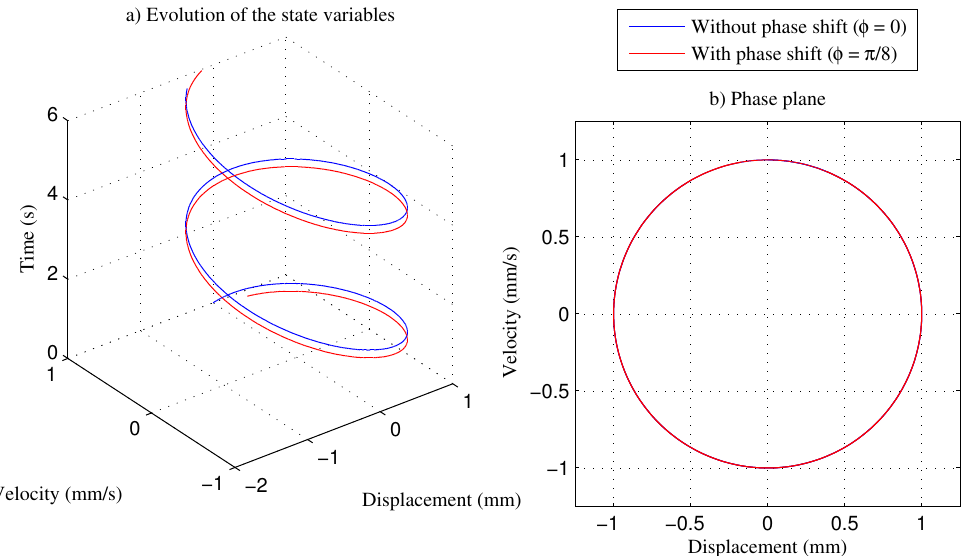
Figure 5. Evolution of the state variables and phase plane for x = sin ( 2 t + φ ) , ˙ x = 2cos ( 2 t + φ ) and φ = [ 0, π /8 ]